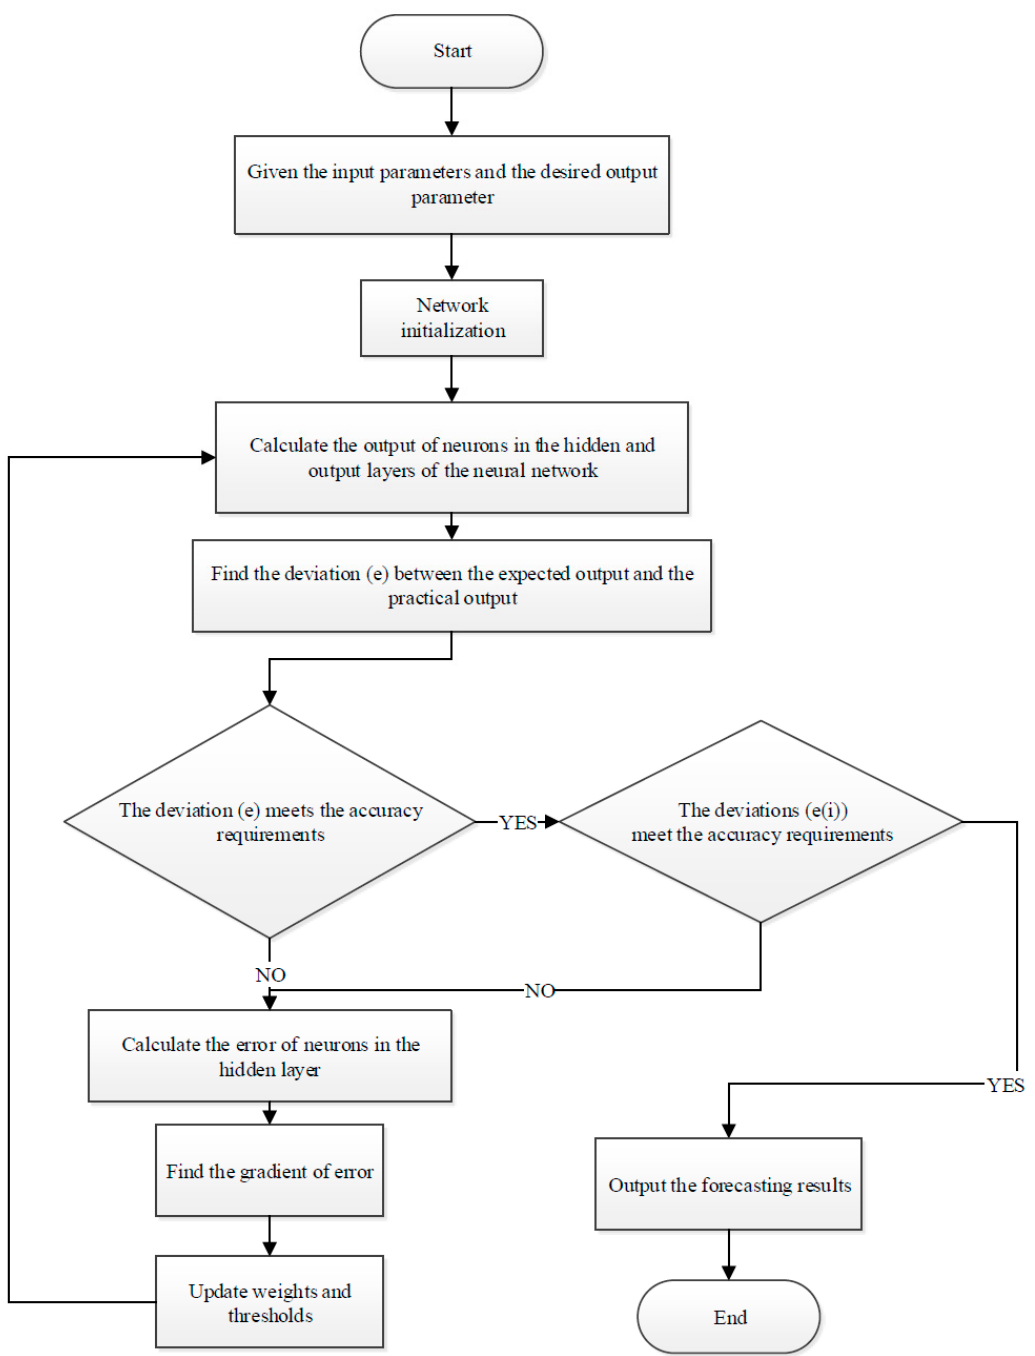
Figure 6. Power forecasting flow chart with a BP neural network.